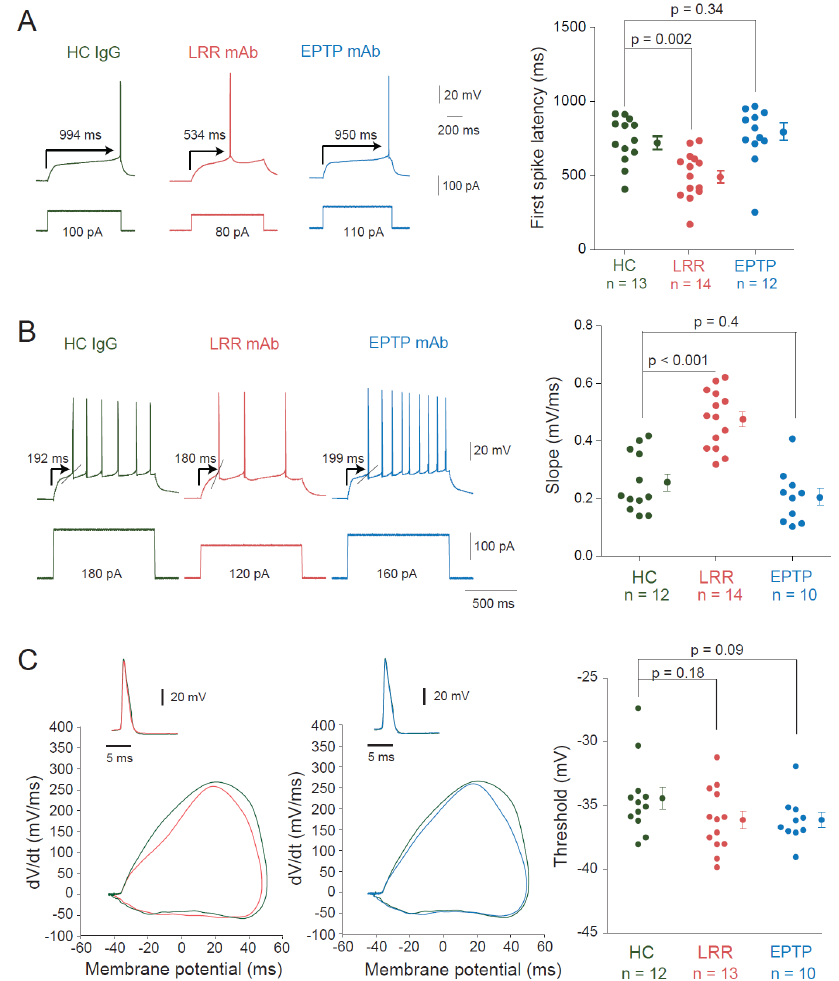
Figure 3. Changes in the spike latency and slope in neurons treated with LRR-mAbs. ( A ) Left, representative traces at the rheobase of neurons treated with HC IgGs (green), LRR-mAbs (red), and EPTP-mAbs (blue). Arrows indicate the latency to the first spike. Right, graph of the latency to the first spike at the rheobase current for each condition. ( B ) Left, the slope of the membrane potential trajectory before the AP is illustrated by the oblique line in the traces ( left ) and the values were reported in the graph ( right ). ( C ) Unchanged spike threshold. Left, comparison of action potential phase plots in LRR- (red) and HC- (green) treated neurons. Middle, comparison of action potential phase plots in EPTP- (blue) and HC- (green) treated neurons. Right, group data. Statistics were per- formed using Mann–Whitney U-test.